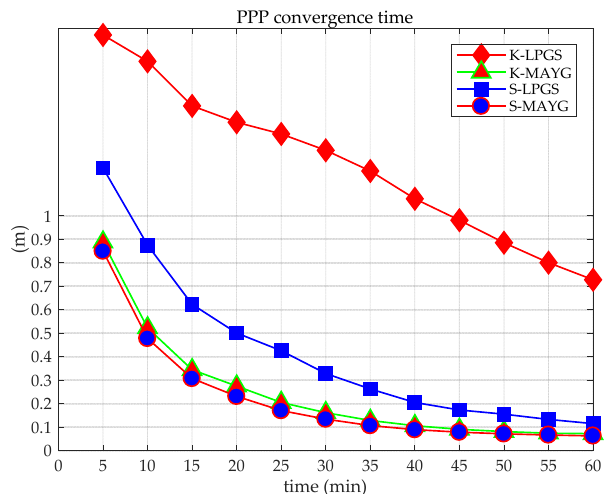
Figure 12. Positioning convergence in the first hour of LPGS and MAYG stations perform PPP.